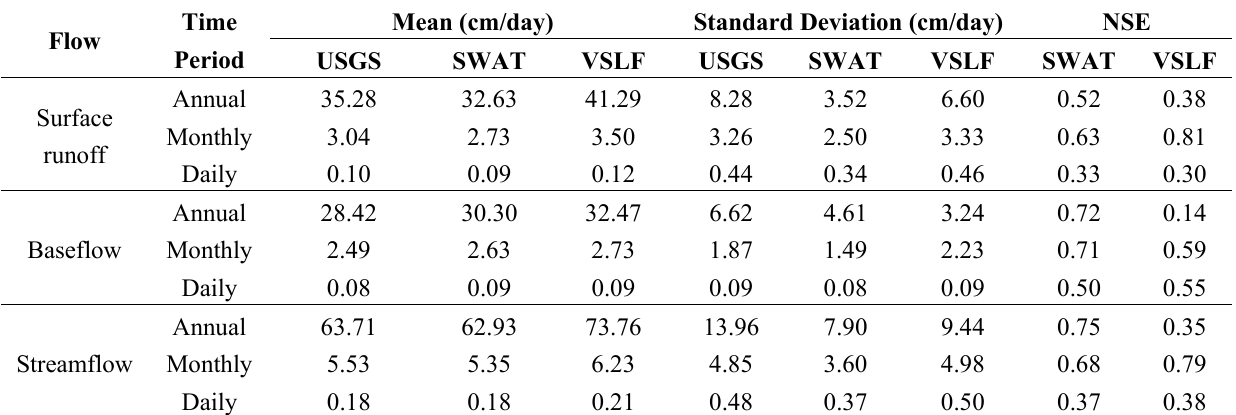
Table 4. Comparison of daily, monthly, and annual streamflow and its two components, surface runoff and baseflow, during the validation period 2003–2008.